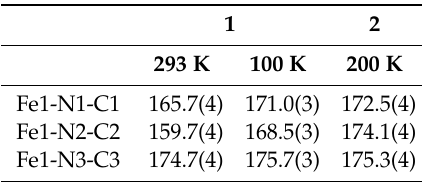
Figure 3. Infrared spectra for compounds 1 ( a ) and 2 ( b ) in the 2150–2200 cm −1 region, showing the principal bands that are temperature sensitive.